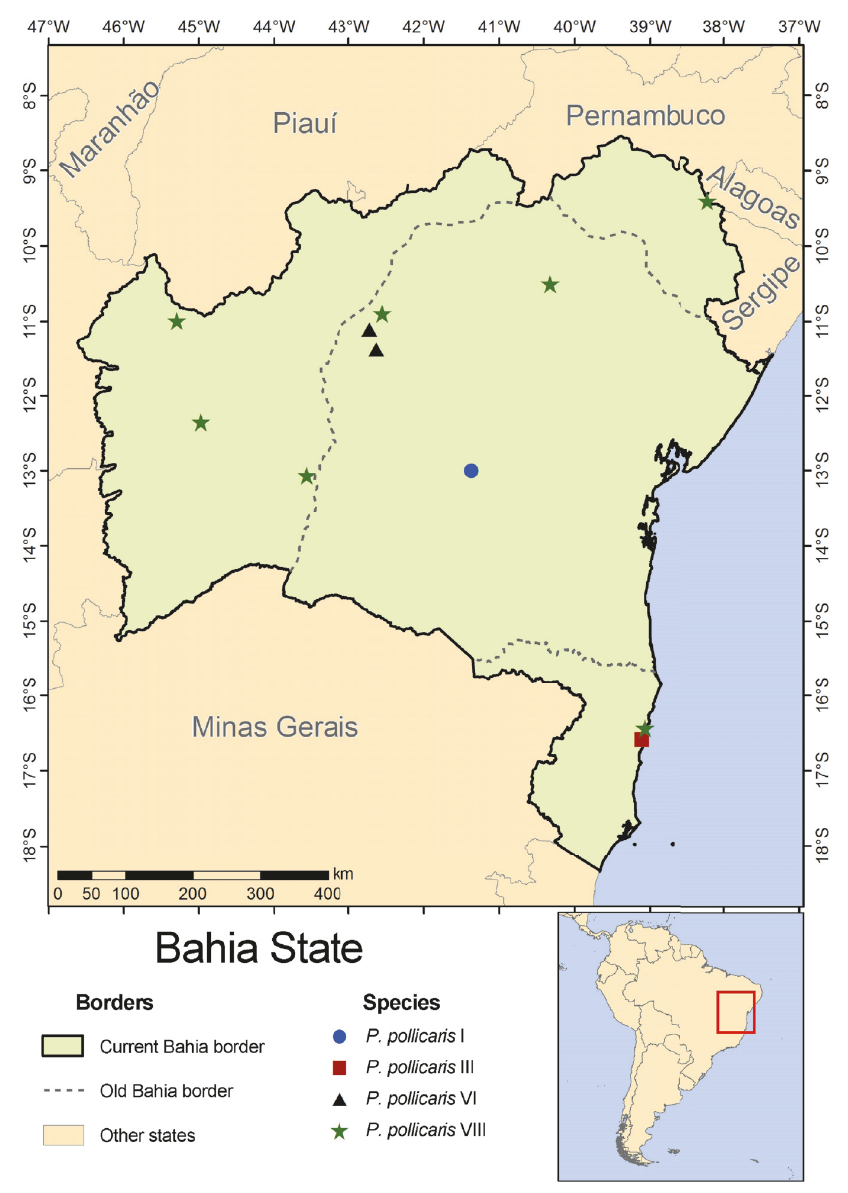
Figure 8: Candidate species present in the Brazilian State of Bahia (type locality for P. pollicaris ), considering current and old